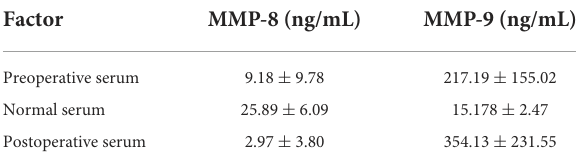
TABLE 4 Concentration of MMP-8 and MMP-9 in the normal, preoperative, and postoperative groups ( p <